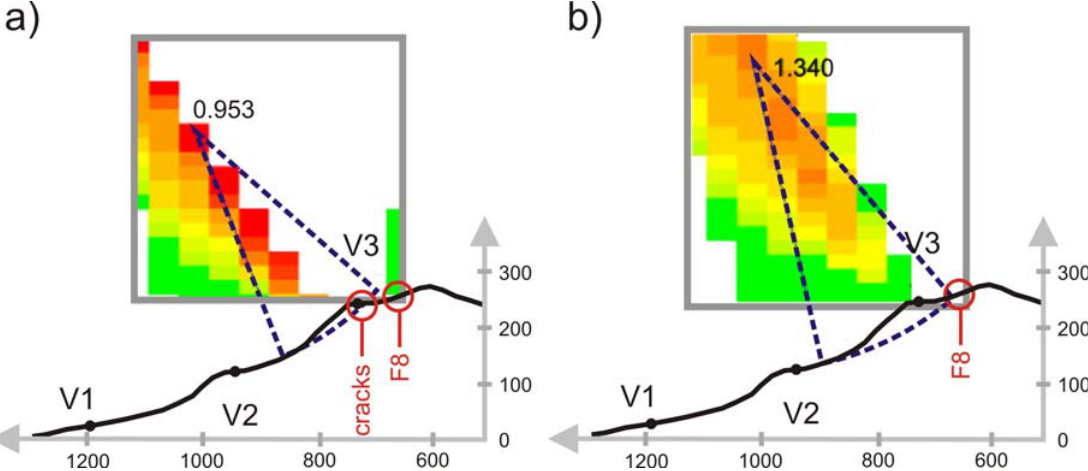
Figure 8. N-S cross-section for the 2D stability analysis based on recognition of the most critical slip circles for two scenarios. ( a ) First scenario: the position of the furthest moving benchmark (F8) and that of the ground cracks are constrained. ( b ) Second scenario: only the position of F8 is constrained. Color scale indicates the safety factors, F , that correspond to different positions of the center of the theoretical slip circle (incipient instability conditions for 1 < F ). The GPS benchmark V2 is now the continuous station